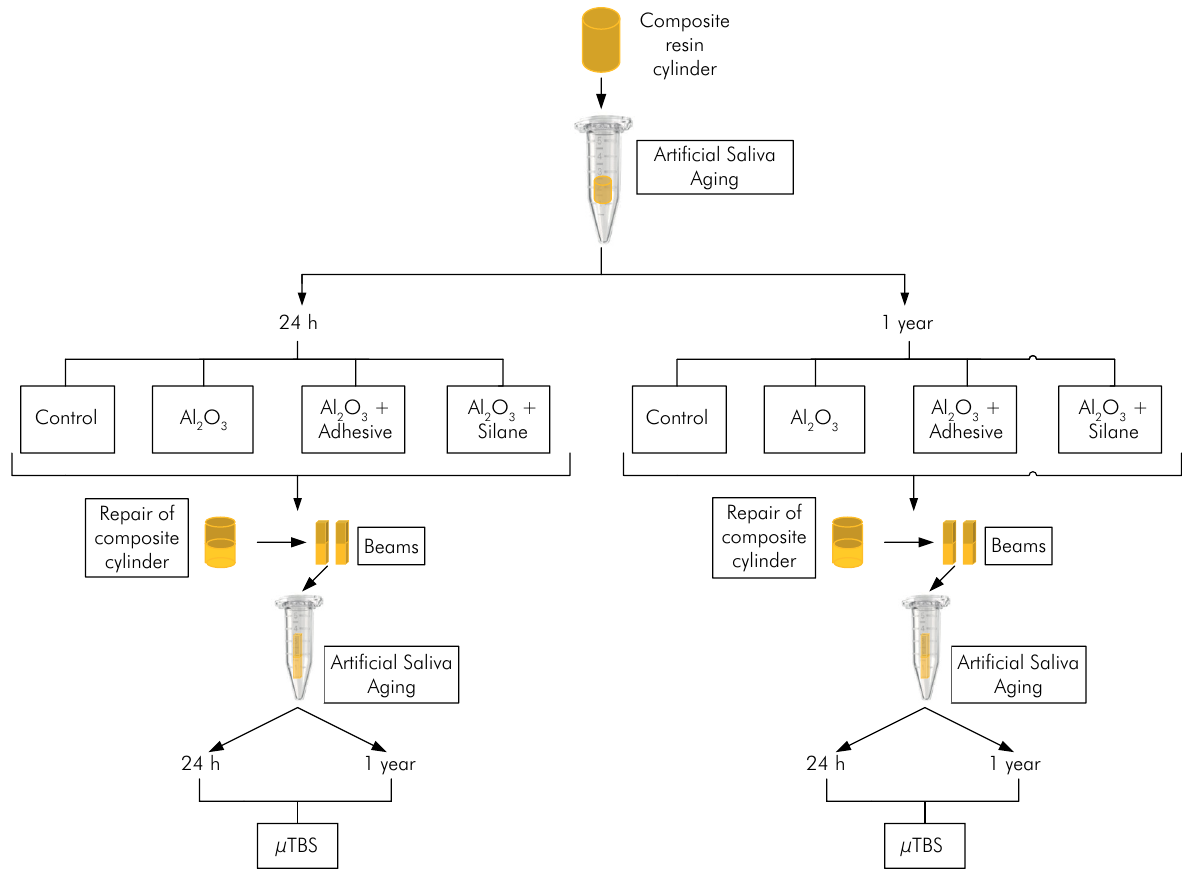
Figure. Methodological study design according to storage time (24 hours and 1 year) of composite resin and repair restoration.